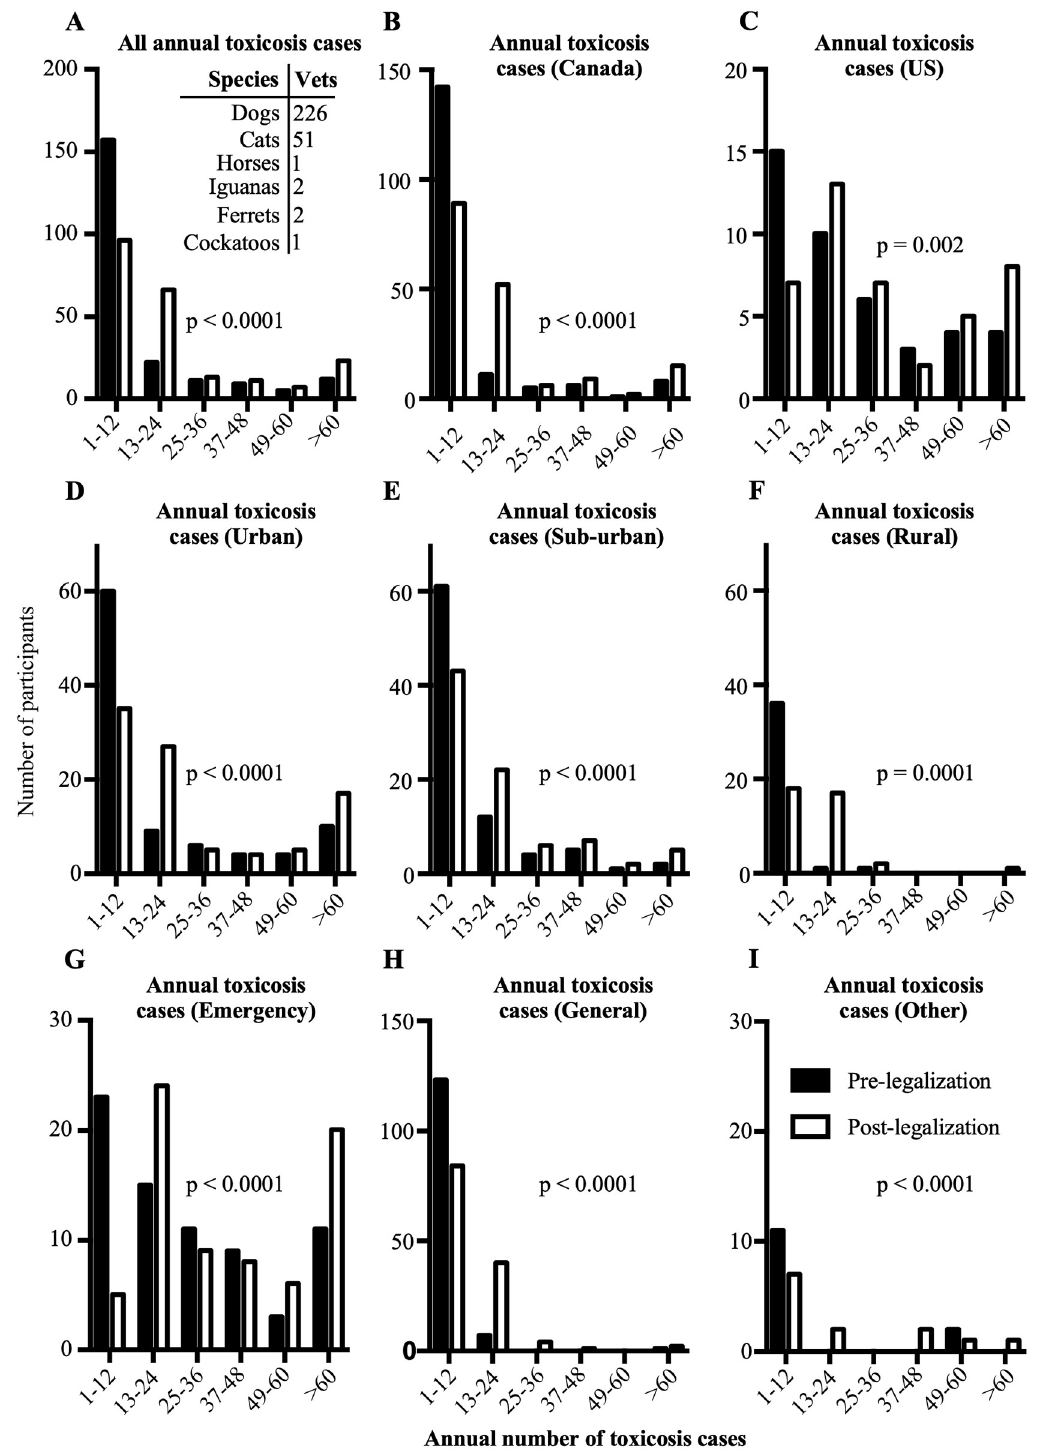
Fig 2. Reported annual number of toxicosis cases before and after October 2018. A. All reported annual cannabis toxicosis cases pre- and post-legalization. Inset: Species in which cannabis toxicosis was observed and the number of participants who reported them. B. Reported annual cannabis toxicosis cases pre- and post-legalization in Canada. C. Reported annual cannabis toxicosis cases before and after October 2018 in the US. D. Reported annual cannabis toxicosis cases pre- and post-legalization in urban settings. E. Reported annual cannabis toxicosis cases pre- and post-legalization in sub-urban settings. F. Reported